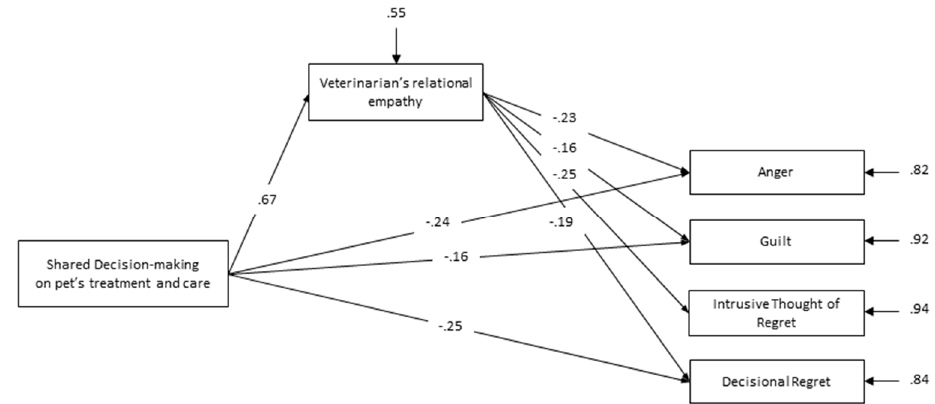
Figure 1. Path analytic model of the effects of shared decision-making related to pet’s treatment and care and veterinarian’s relational empathy on psychological distress for losing a pet (Coefficients are standardized structural coefficients).